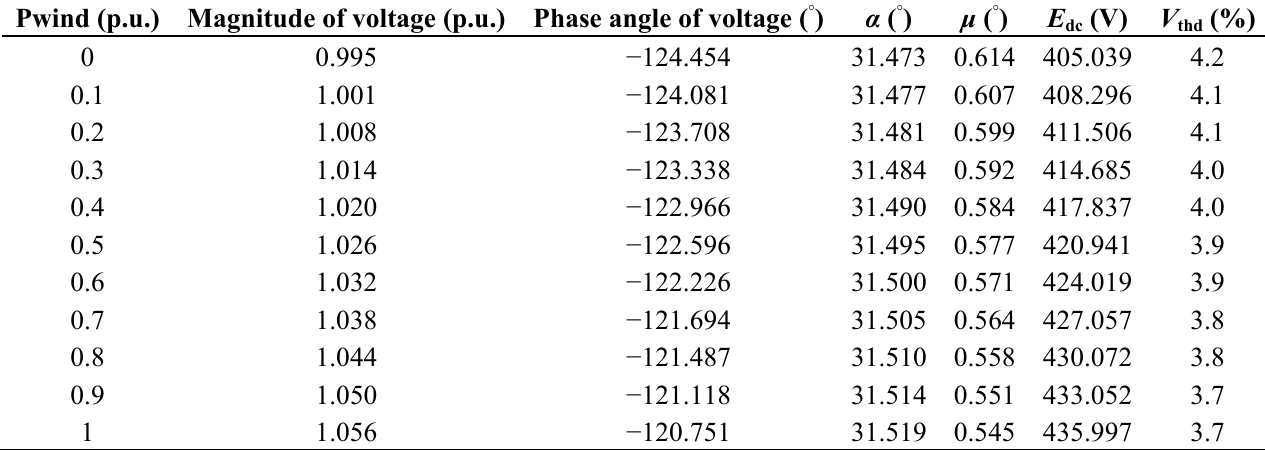
Table 4. The parameters and harmonic distortion level of the nonlinear load at bus 12. Pwind